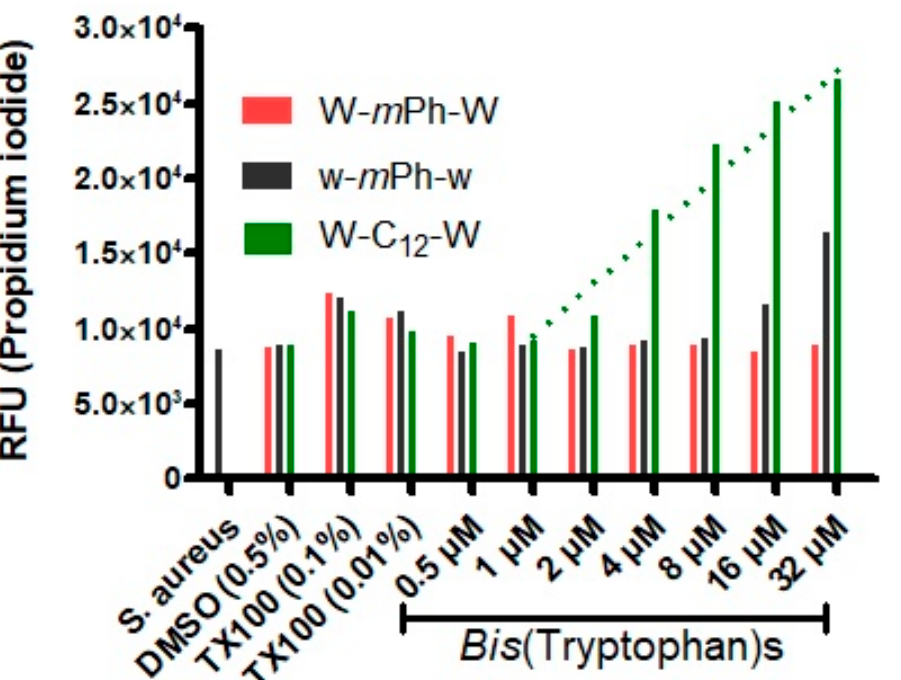
Figure 5. Structures of propidium iodide ( left ) and ethidium bromide ( right ), non-membrane per- meable, fluorescent agents that stain by DNA intercalation.